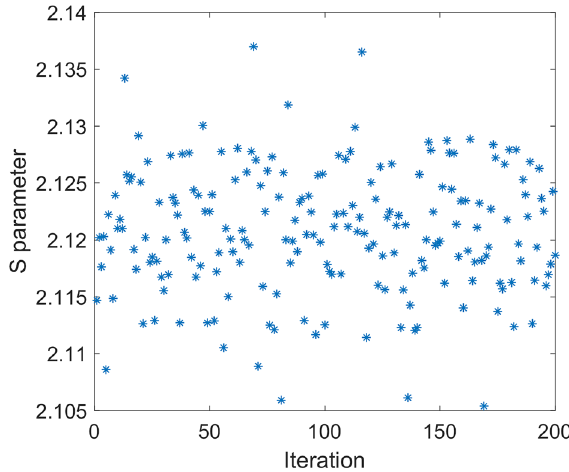
Figure 7. S parameter for 200 runs. In each run size of the input vector is 100,000. Polarization of photons that hit B polarizer obeys (22). Mean value of calculated S parameter in this example is equal to 2.121 while angles of